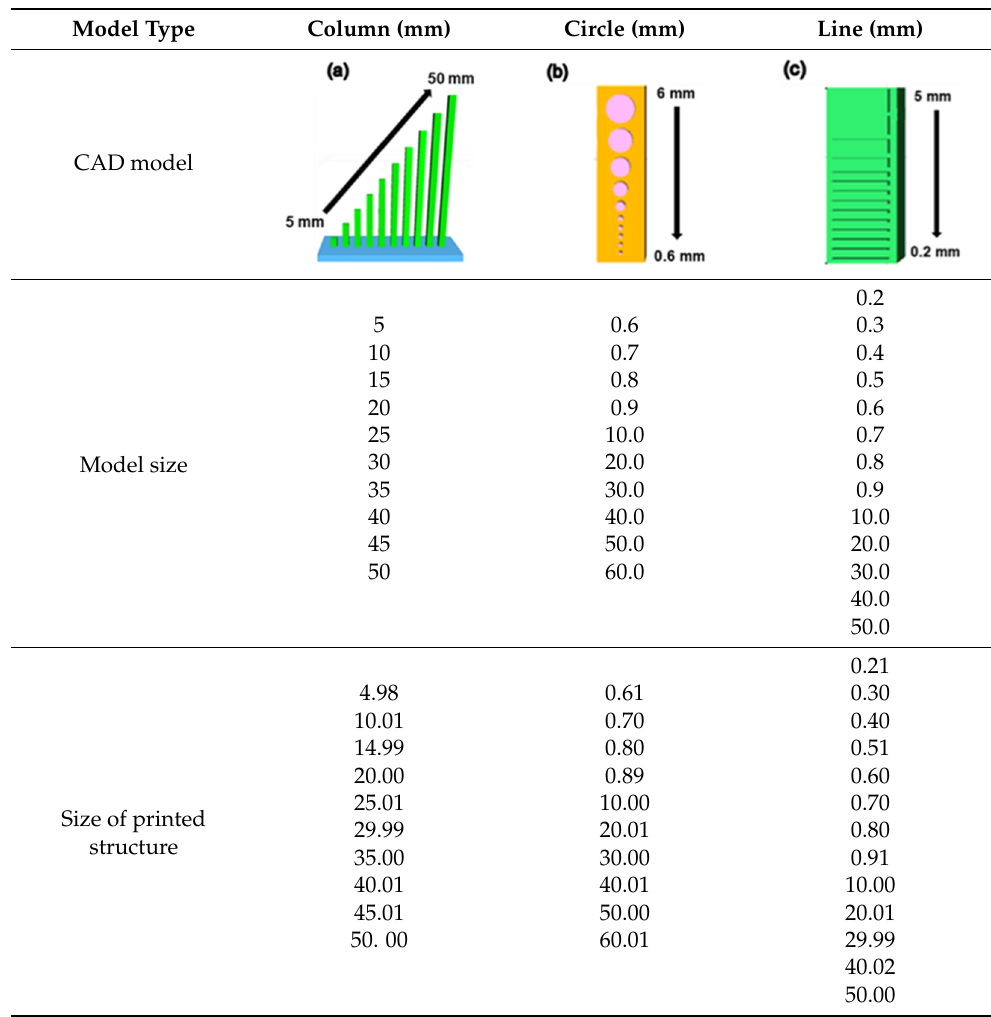
Table 5. Summary of the resin resolution, calculated by CAD photograph (a) Column, (b) Circle, and (c) Line structure.